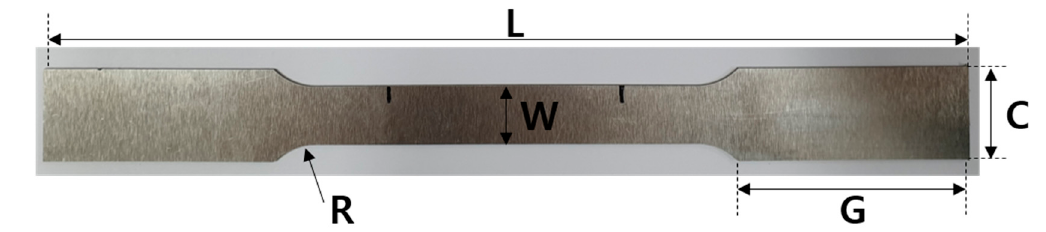
Table 1. Material constants of Al 6061-T6.